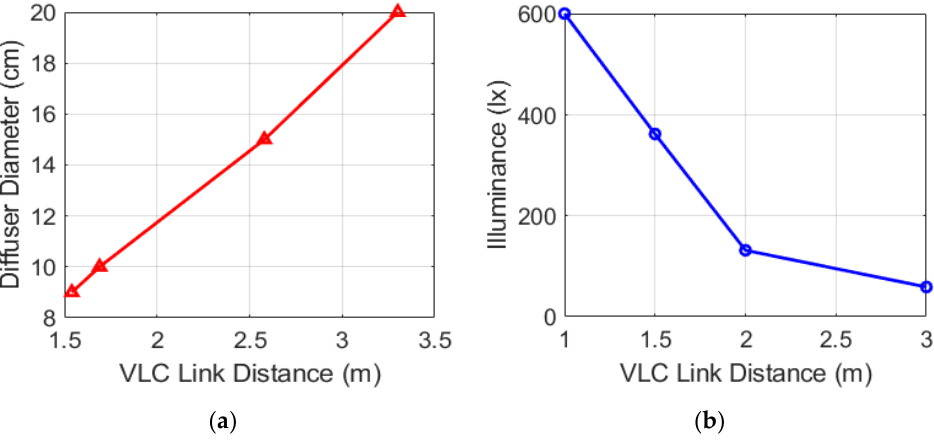
Figure 9. Impact of diffuser diameter and illuminance of lightbulbs on the VLC link distance: ( a ) diffuser diameter versus VLC link distance; ( b ) illuminance versus VLC link distance.